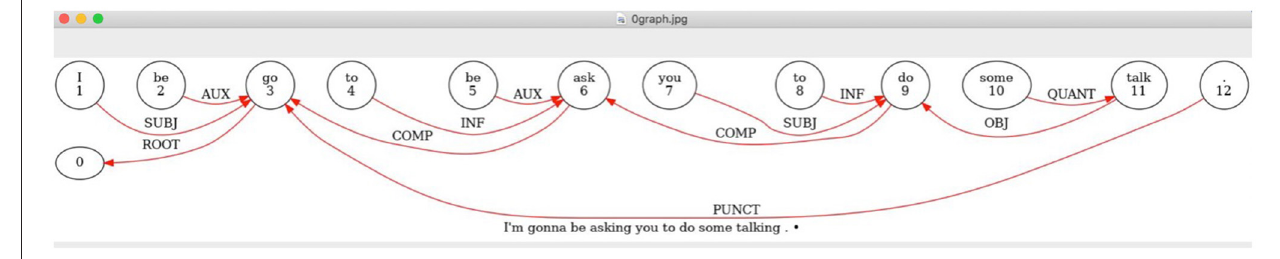
FIGURE 4 | Dependency graph for the first utterance in Figure 3